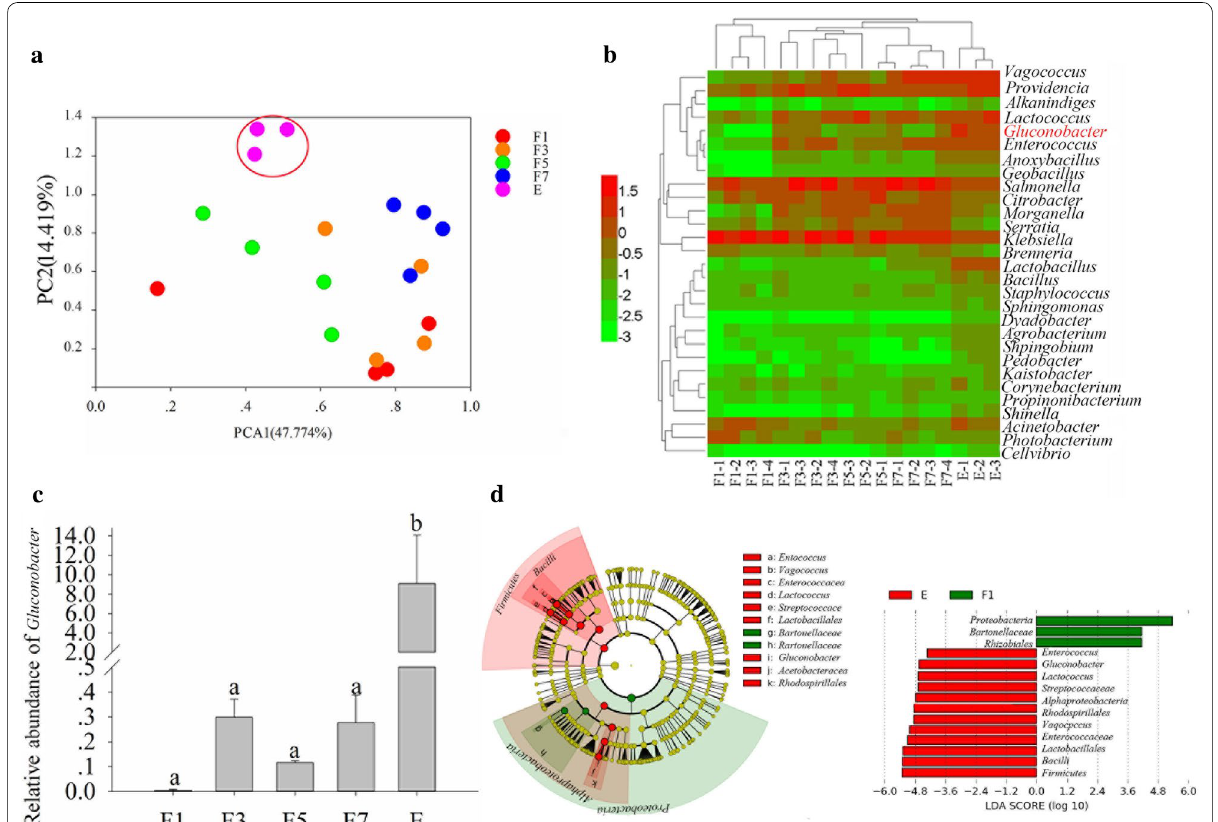
Fig. 1 Bacterial communities in the ovaries of flies. a Principal components analysis of bacterial communities. b Cluster analysis cladogram show- ing the identified bacteria. The data were log transformed before plotting. c Difference in abundance of Gluconobacter sp. d Key factor screening for differences between samples by LEfSe analysis, the biomarkers with LDA scores above 4.0 were showed in green or red dots in the cladogram. Means ( SEM) that are labeled with different letters are significantly different; F1: ovary of a female fly 1 day after emergence; F3: ovary of a female ± fly 3 days after emergence; F5: ovary of a female fly 5 days after emergence; F7: ovary of a female fly 7 days after emergence; E: ovary of a female fly with developed